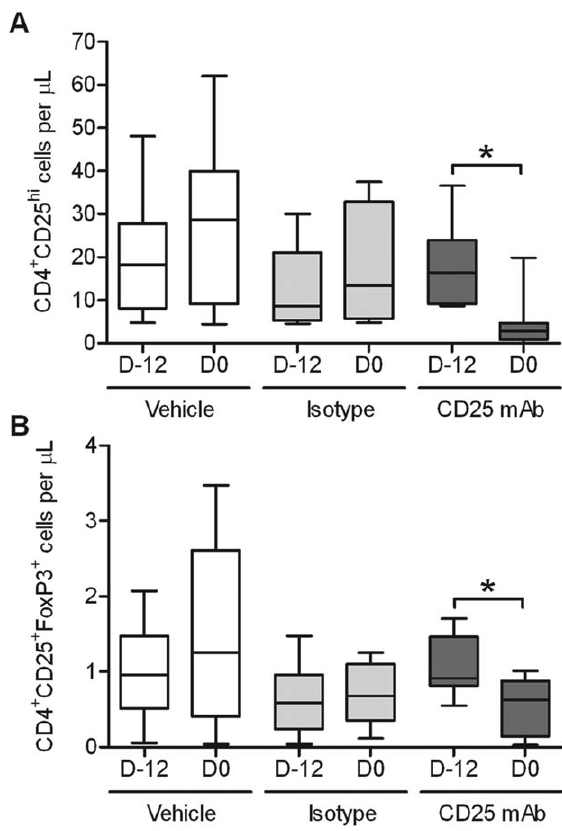
Figure 1. Anti-CD25 monoclonal antibody treatment depletes Treg cells in cats. Cats received 9 mg/kg anti-CD25 mAb (9F23) (n=8) or 9 mg/kg isotype control mAb (CRL-1689) (n=8) i.p. on day 2 12. A third group of cats received 3 mL/kg saline on day 2 12 (n=8). (A) PBMCs were labeled with antibodies for CD4 and CD25 and analyzed by flow cytometry for CD4 + CD25 hi percentages within the lymphocyte population on days 2 12, 0, 7, 14, 35, and 54 post-FIV infection. Percentages were multiplied by lymphocyte absolute number to quantify absolute numbers of CD4 + CD25 hi cells. (B) CD4 + CD25 + FoxP3 + cell percentages were determined by flow cytometry. CD4 + CD25 + FoxP3 + absolute number was calculated. Mean 6 SEM is shown. * indicates p , 0.05.